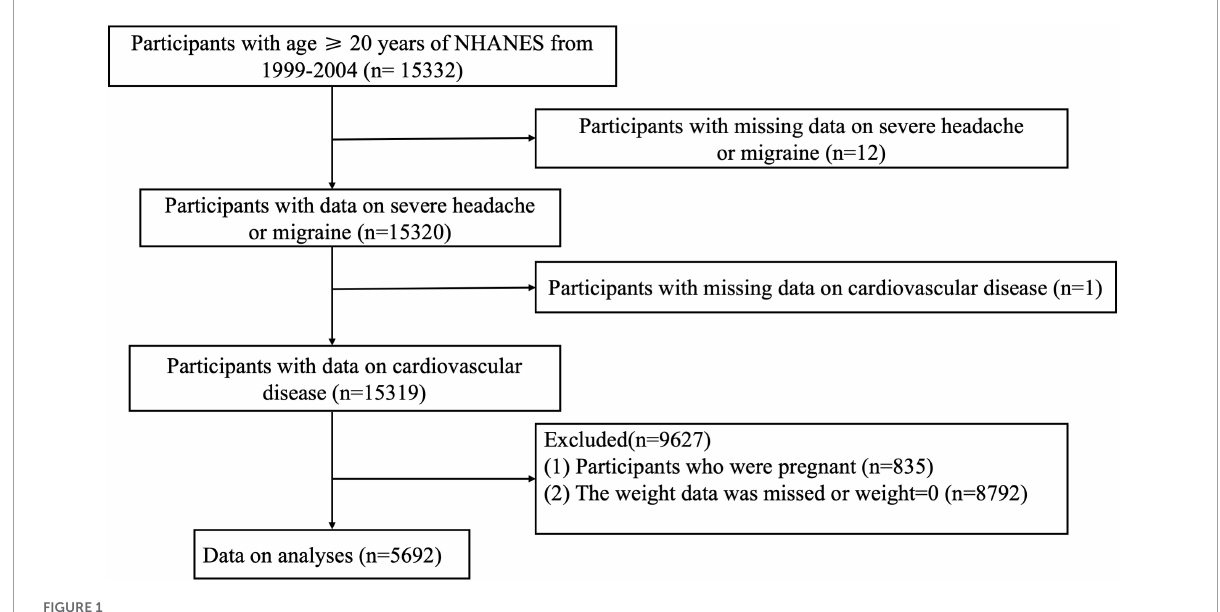
FIGURE1 Detailed information about subject